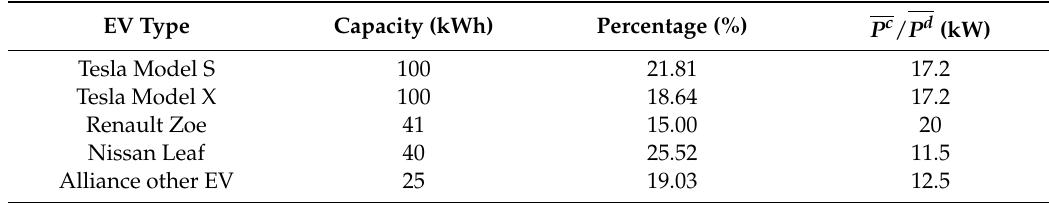
Table 2. Simulation of di ff erent EVs [31]. Reprint with permission [31]; 2018,